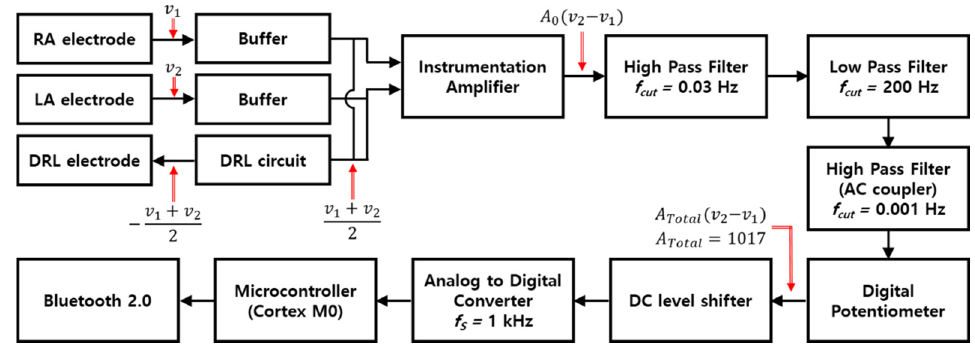
Figure 1. Block diagram of ECG measurement